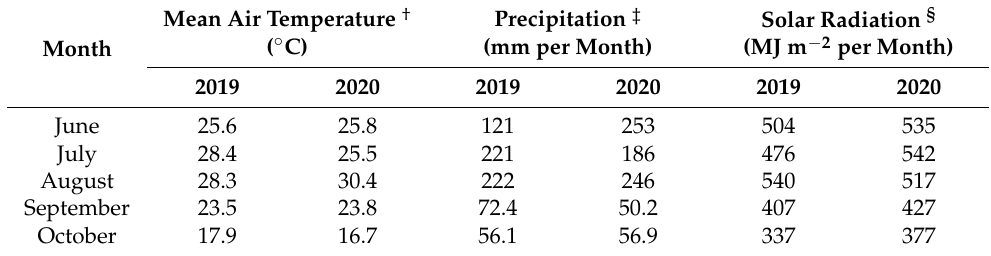
Table 1. Mean air temperature, precipitation, and solar radiation during the rice growing